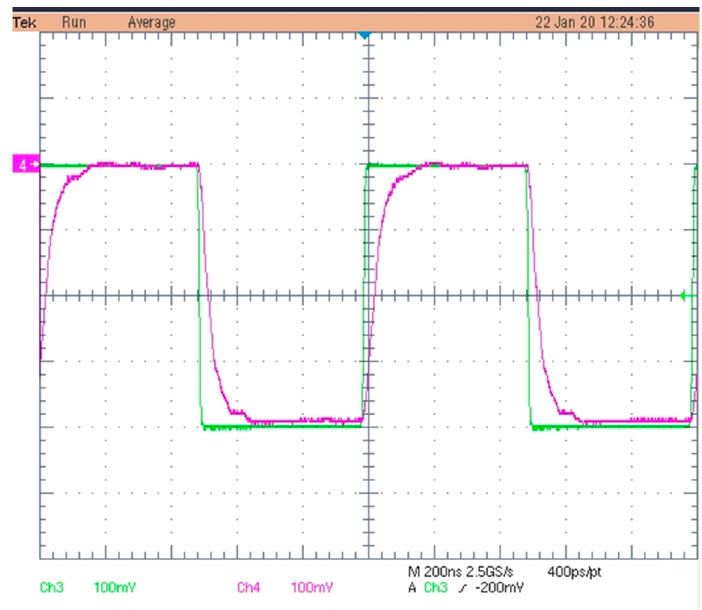
Figure 10. Measured transient response to a square input signal.